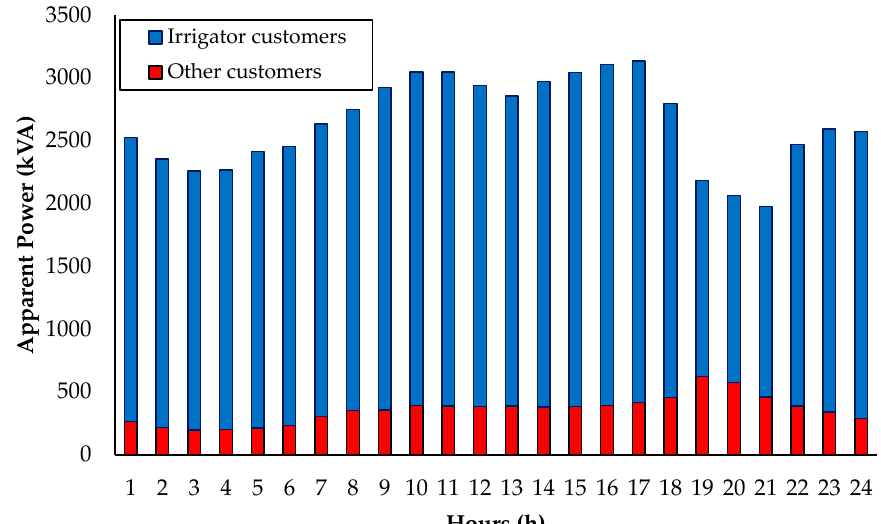
Figure 23. Load distribution on the Rural Feeder C. Source: The authors.